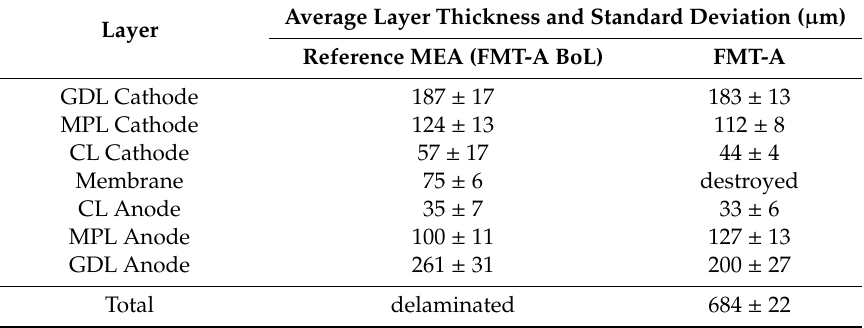
Table 3. Average layer thicknesses of FMT-A BoL and FMT-A determined by